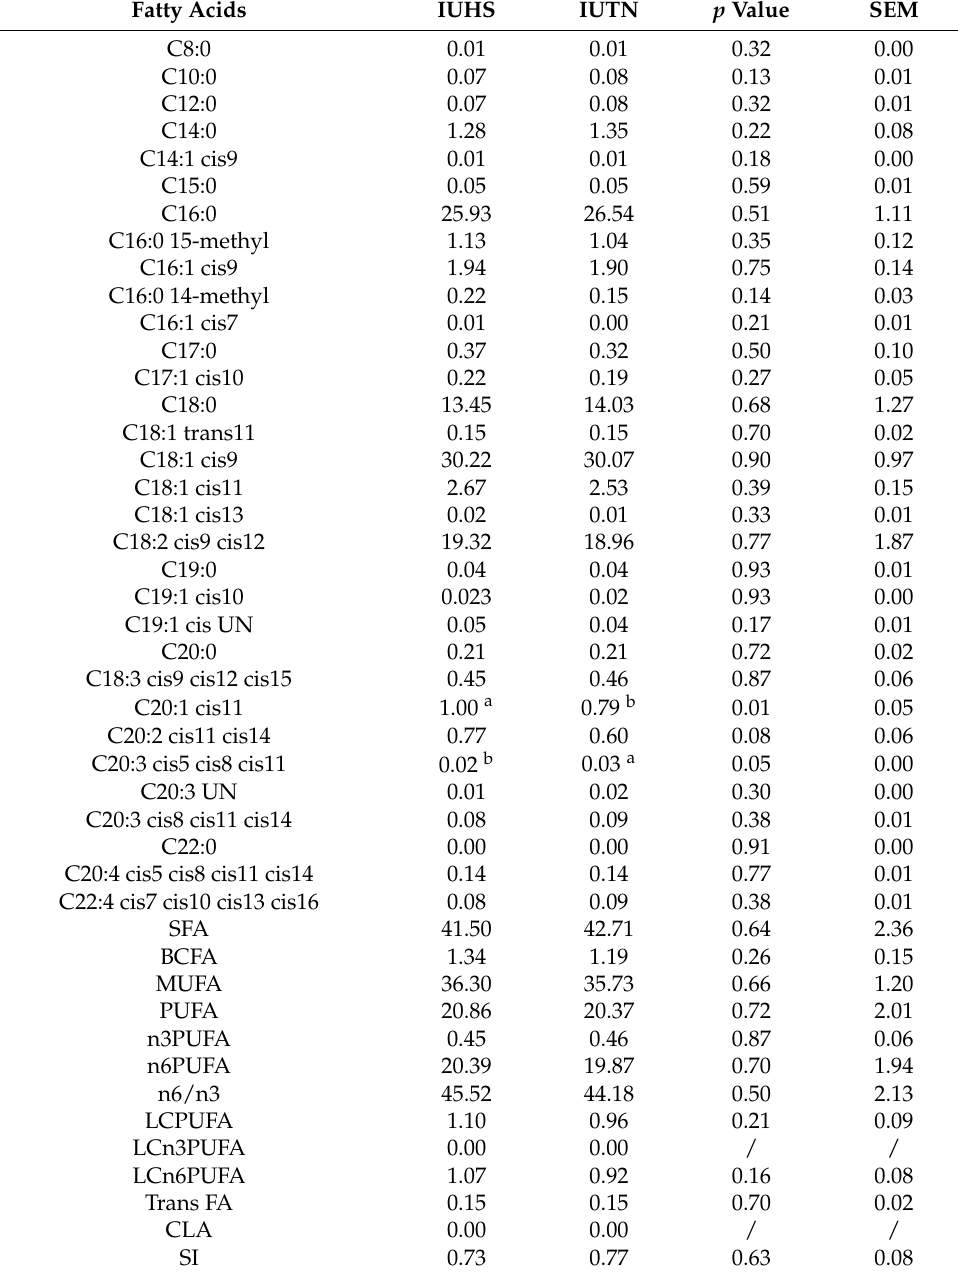
Table 7. Fatty acid profiles of subcutaneous fat collected from either in utero heat stress (IUHS) or in utero thermoneutral (IUTN)